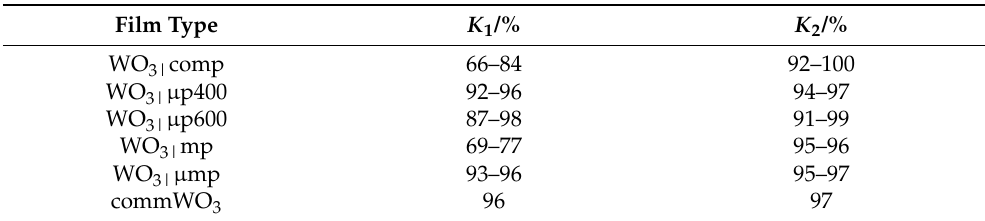
Table 6. Reversibility of the electrochromic switching determined from the first ( K 1 ) and second ( K 2 ) cycle of the CV measurements at a scan rate of 5 mVs − 1 measured for at least 2 specimens of a given kind (commWO 3 only measured once).